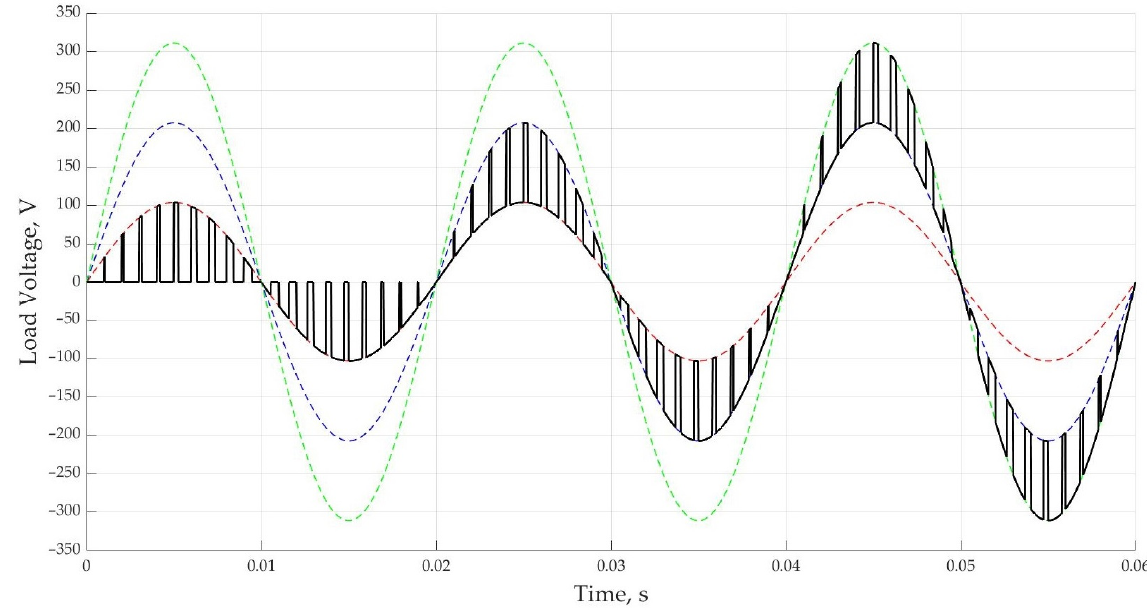
Figure 8. Oscillograms of load voltage in dynamics.